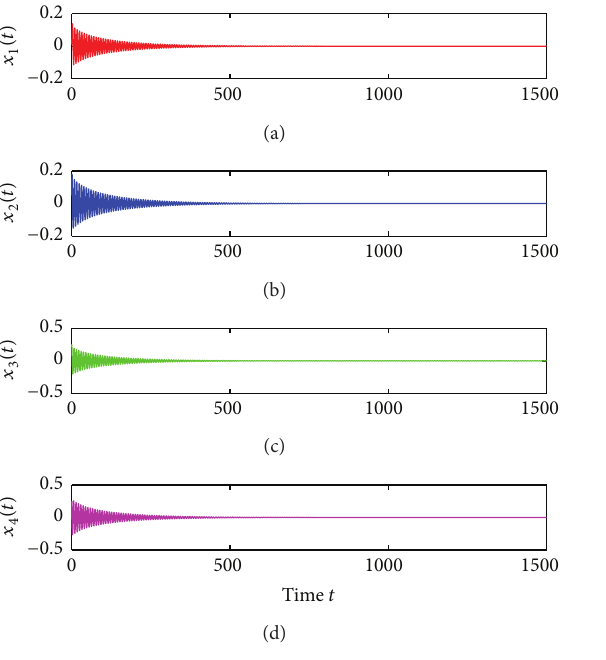
Figure 13: The trajectory of 𝑥 1 , 𝑥 2 , 𝑥 3 , and 𝑥 4 when 𝜏 2 = 1.65 < 𝜏 ∗ = 0.35 . 1.7488 = 𝜏 ∗ 2 and 1